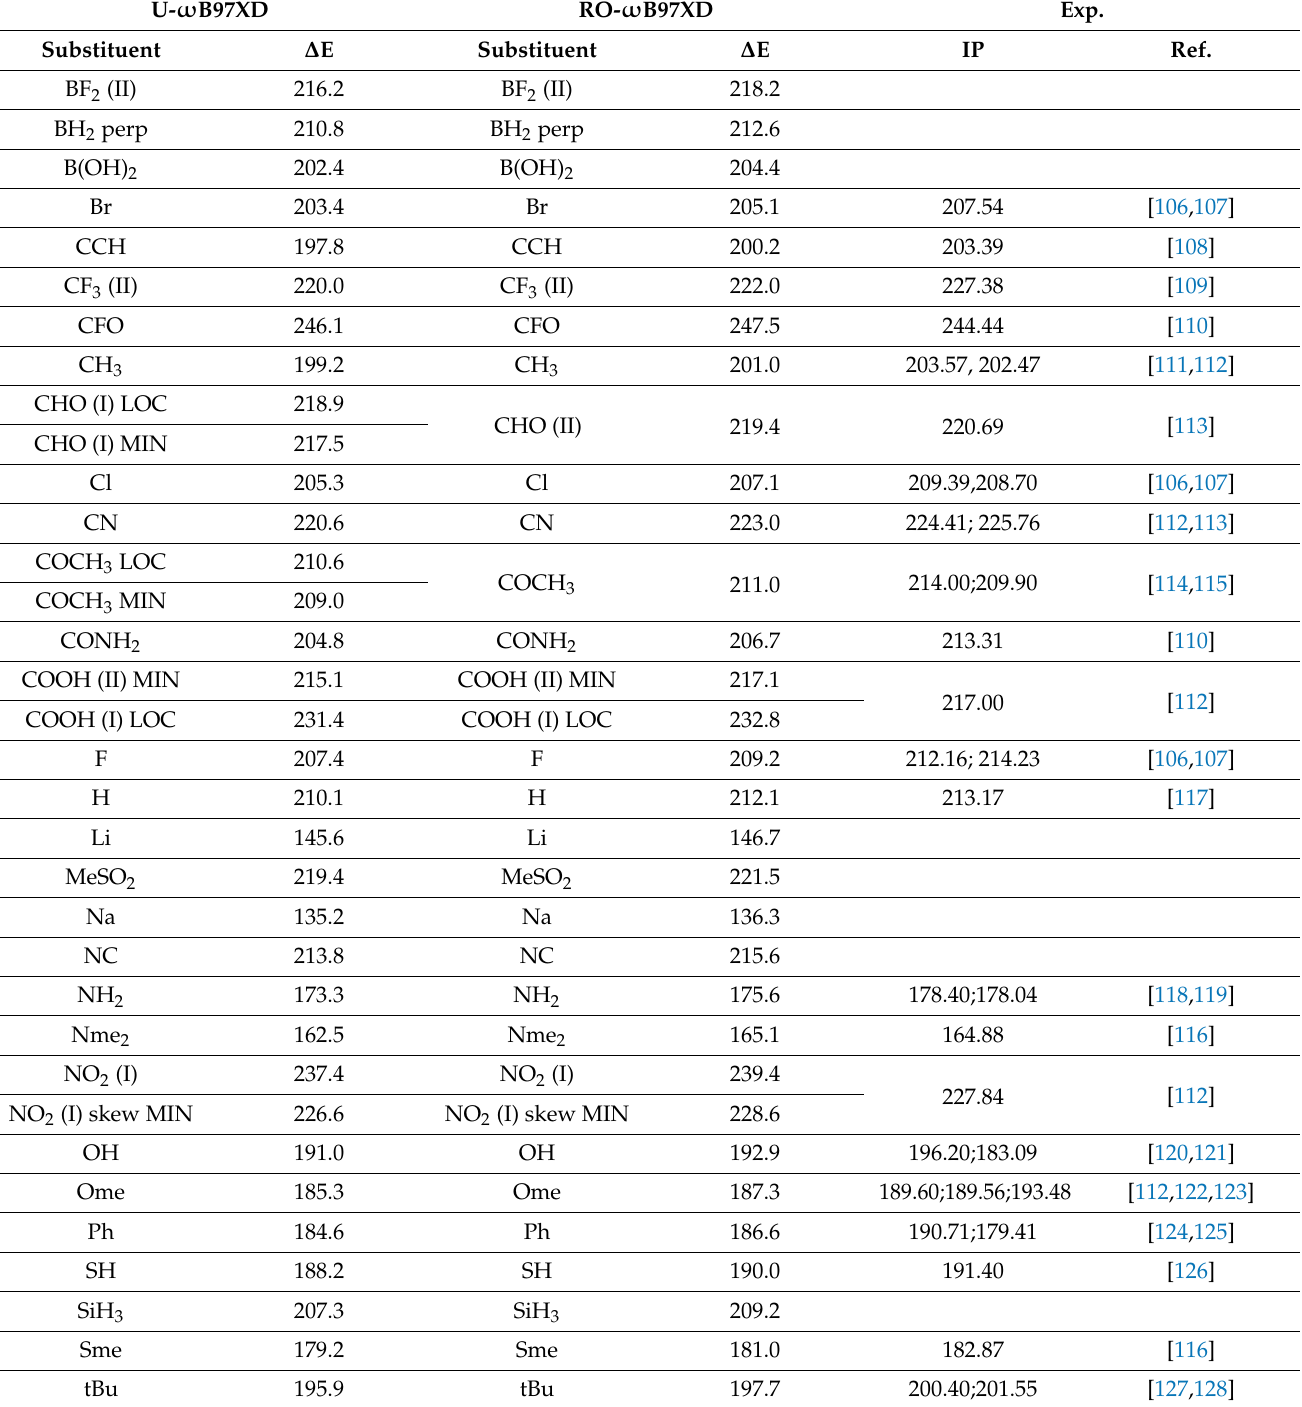
Table 1. Comparison of relative values of the total energies ( ∆ E, kcal/mol) of monosubstituted benzene monocation radicals. U- ω B97XD RO- ω B97XD